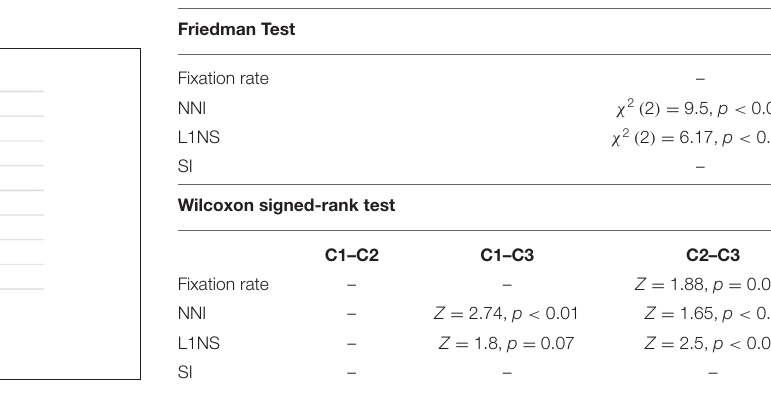
TABLE 12 | Summary of analysis of ocular